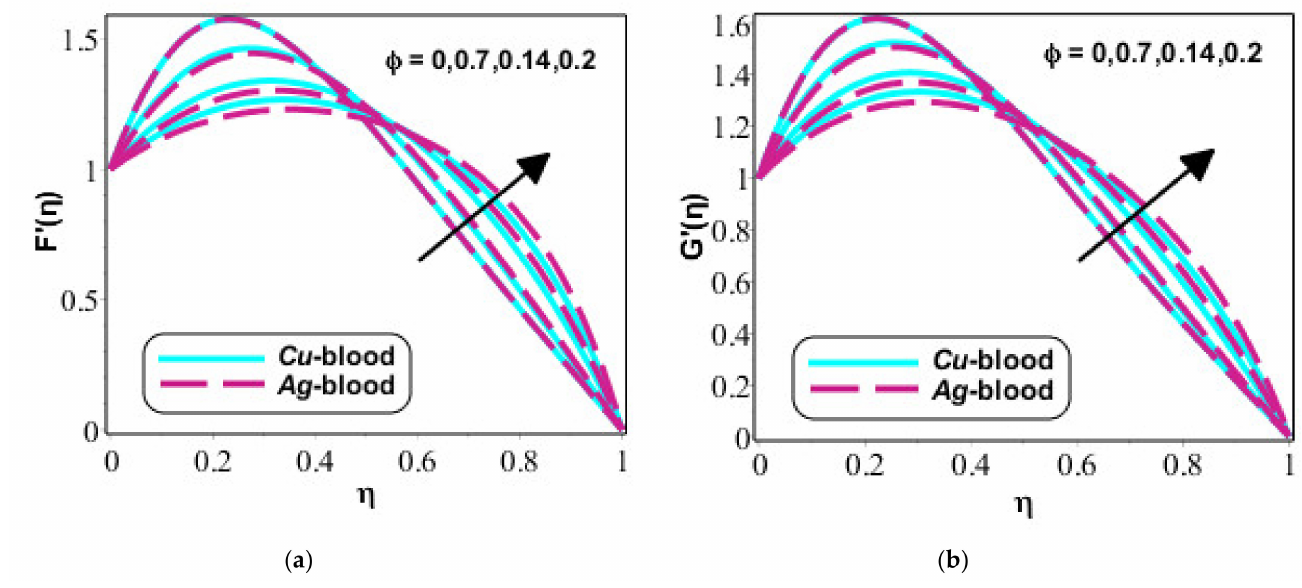
Figure 6. Behaviour of ( a ) F (cid:48) ( η ) and ( b ) G (cid:48) ( η ) as varying φ when λ = 2, Re = 5, β i = 1.5, β e = 2, M =